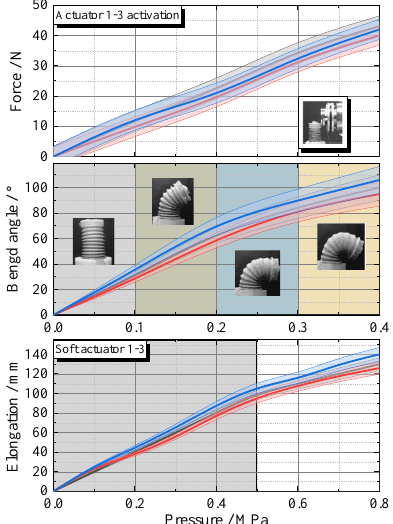
Figure 8. Static pressure test results for one soft joint.